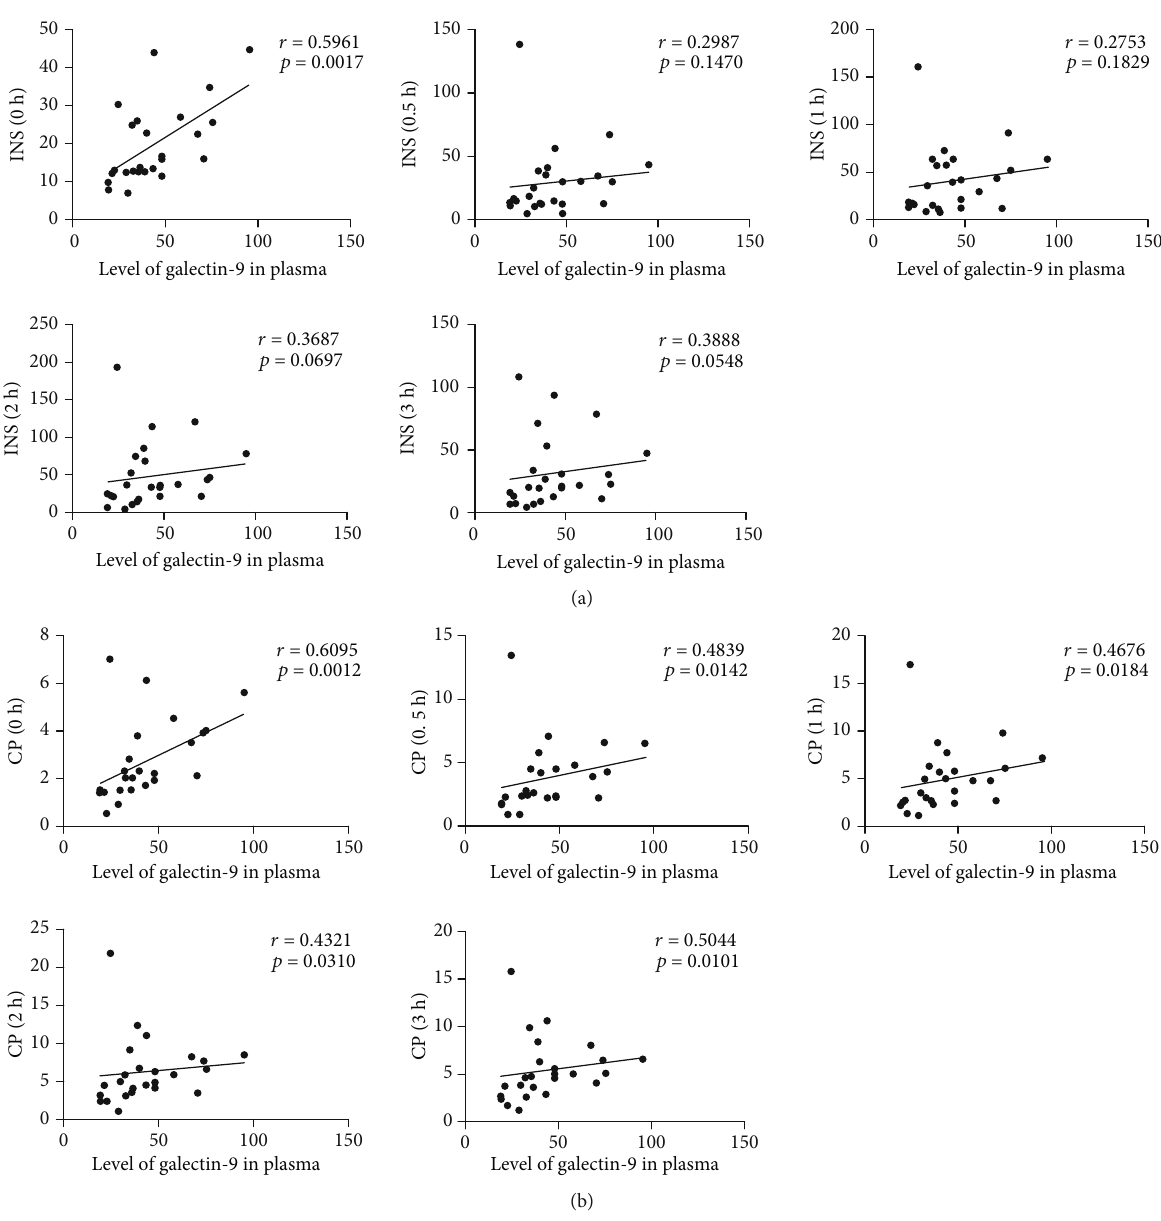
Figure 4: Correlation between galectin-9 level and indicators of islet function in obese T2DM patients. (a) Correlation between galectin-9 level and insulin (INS) at 0min (0 h), 30 min (0.5h), 60min (1 h), 120 min (2 h), and 180 min (3 h). (b) Correlation between galectin-9 level and C-peptide (CP) at 0 min (0 h), 30 min (0.5h), 60min (1 h), 120 min (2 h), and 180min (3